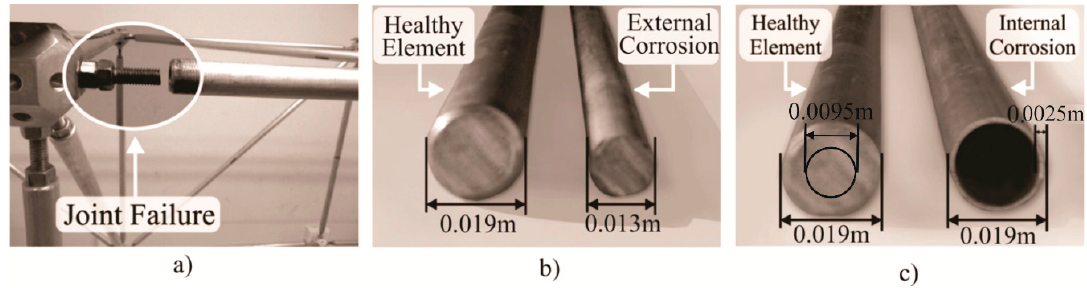
Figure 2. Simulated elements damaged by: ( a ) joint failure, ( b ) external corrosion, and ( c ) internal corrosion.